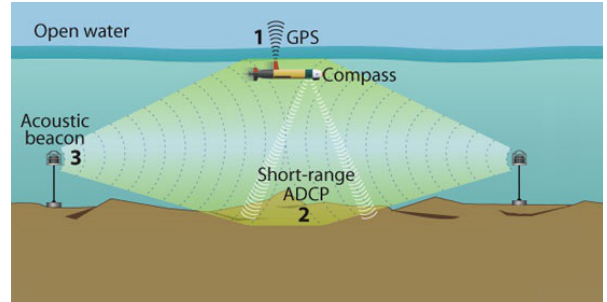
Figure 4: Illustration of an AUV utilizing GPS (1), ADCP (2), acoustic transponders (3), and possibly inertial navigation. Im- age courtesy of Jayne Doucette, WHOI